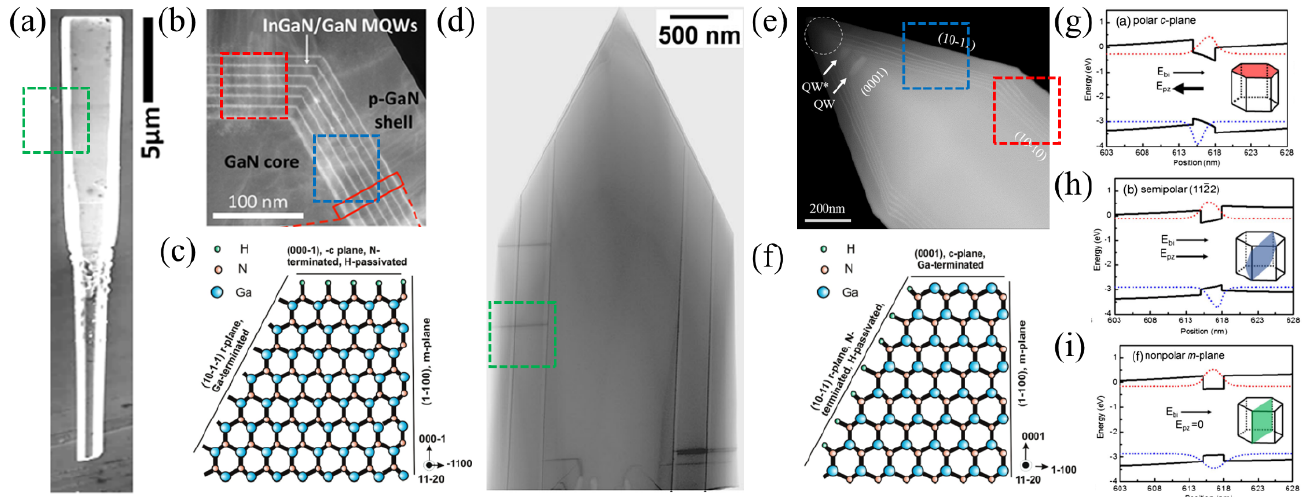
Figure 1. ( a ) SEM image of N-polar microrod. Adapted with permission from Ref. [20]. Copyright 2018 American Chemical Society. ( b ) Cross-sectional STEM-HAADF image of the tip of N-polar microrod. Adapted with permission from Ref. [20]. Copyright 2018 American Chemical Society. ( c )